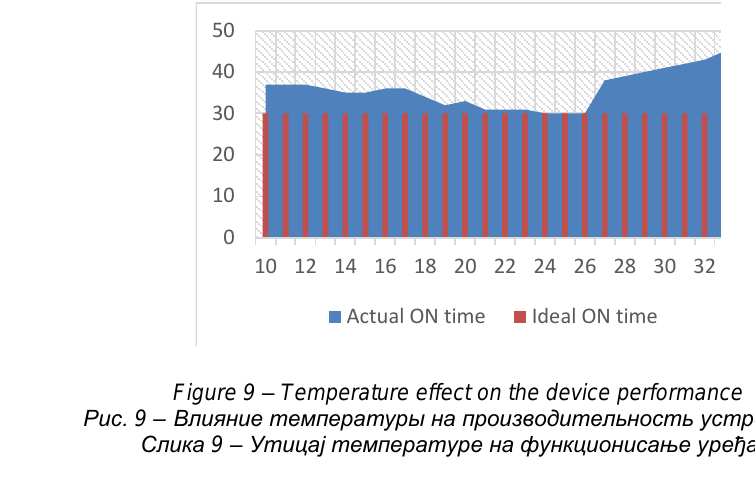
Figure 9 – Temperature effect on the device performance Рис. 9 – Влияние температуры на производительность устройства Слика 9 – Утицај температуре на функционисање